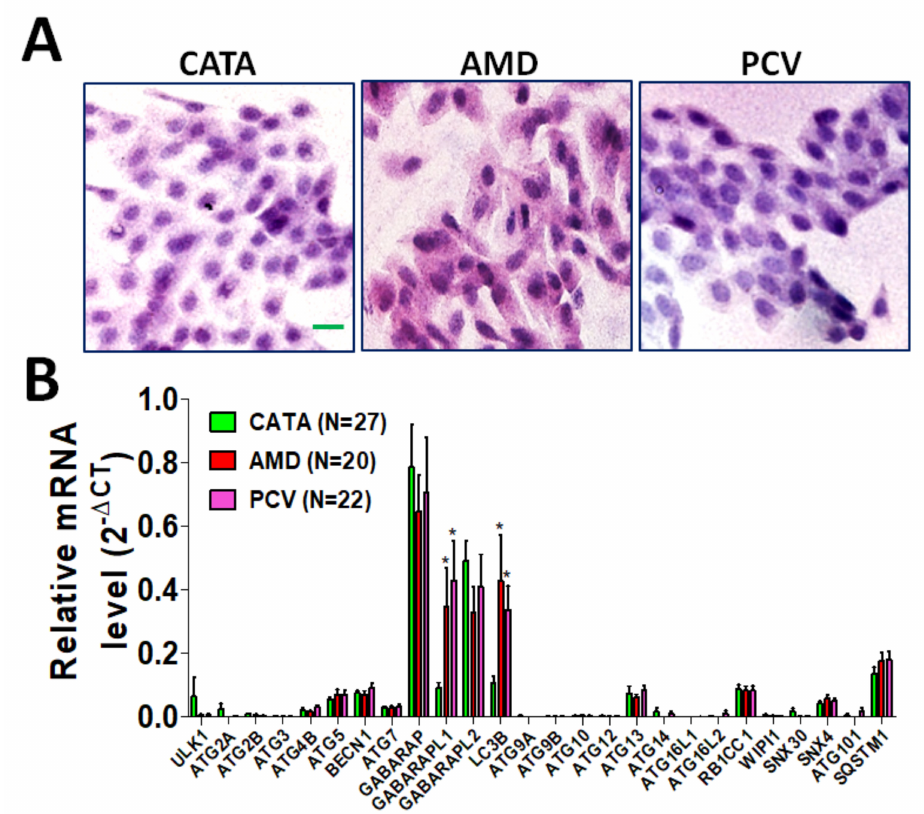
Figure 1. Comparison of autophagy-related genes in different diseases. Seventy samples were obtained from patients with cataracts (CATA, n = 27), neovascular age-related macular degeneration (AMD, n = 20) and polypoidal choroidal vasculopathy (PCV, n = 22) and assessed by using conjunctiva impression cytology. ( A ) The cells were stained by hematoxylin and eosin to observe the cellular and nuclear morphology. Scale bar: 20 µ m. ( B ) The mRNA levels of autophagy-related genes were determined by real-time PCR. The results were analyzed using Prism 5.0. The quantitative results are expressed as the mean ± SD. * p < 0.05 AMD vs. CATA or PCV vs. CATA.